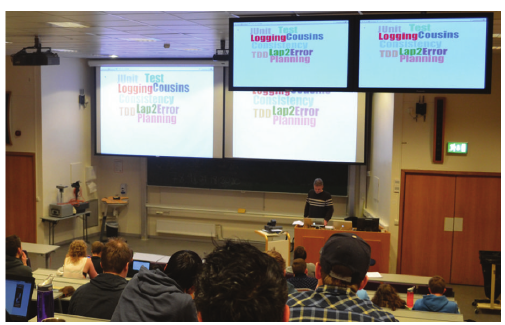
Figure 6: Using the WordCloud application in lecture one.